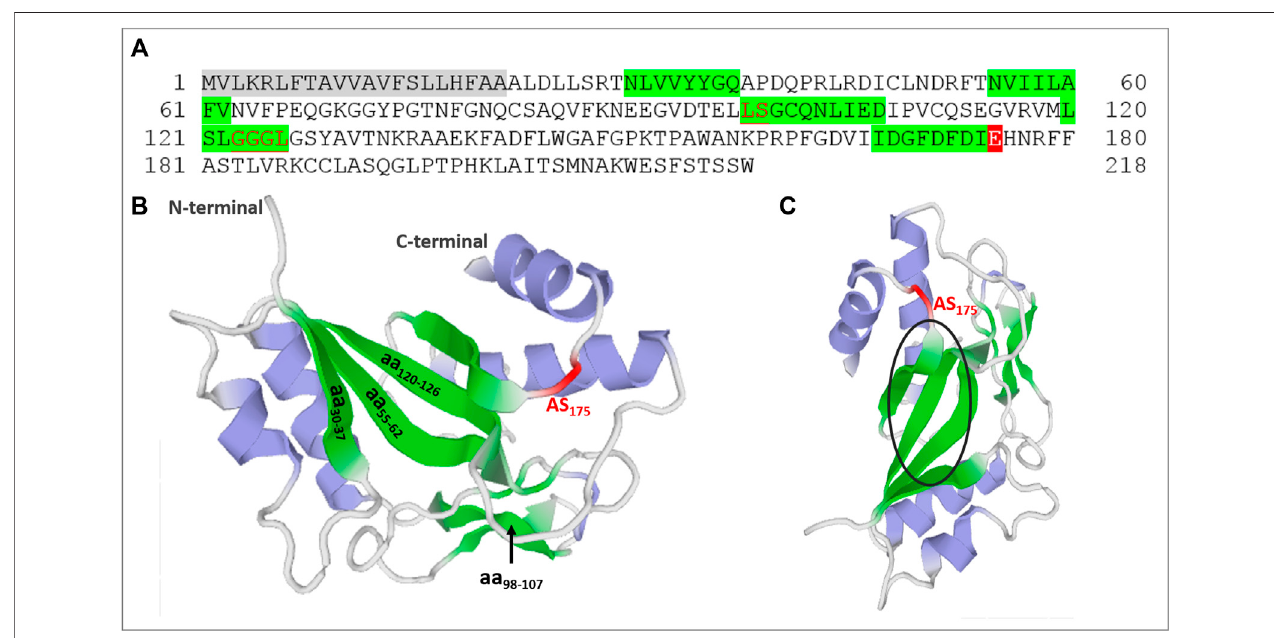
FIGURE 1 | Identi fi cation of catalytic and potential carbohydrate-binding regions in paracoccin (PCN). (A) The PCN amino acid residue sequence (PADG_03,347) from P. brasiliensis used in protein domain analyzes. The gray is the signal sequence, and the red is the catalytic site of the family 18 chitinases domain. Glutamic acid at position175isassociatedwiththecatalyticsiteofthechitinasedomain.ThegreenindicatesregionsofthePCNlikelytobindtocarbohydrates.Theunderlinedredletters werechito-oligosaccharide-bindingregionsdeterminedbyPrositesoftware. (B) MolecularmodelofPCNwithpotentialcarbohydrate-bindingregionsandchitinase active site (AS) identi fi ed in green and red. (C) Molecular model of PCN from another angle (90 o ) with a black circle highlighting the beta sheet tertiary structure in the three-dimensional molecule.